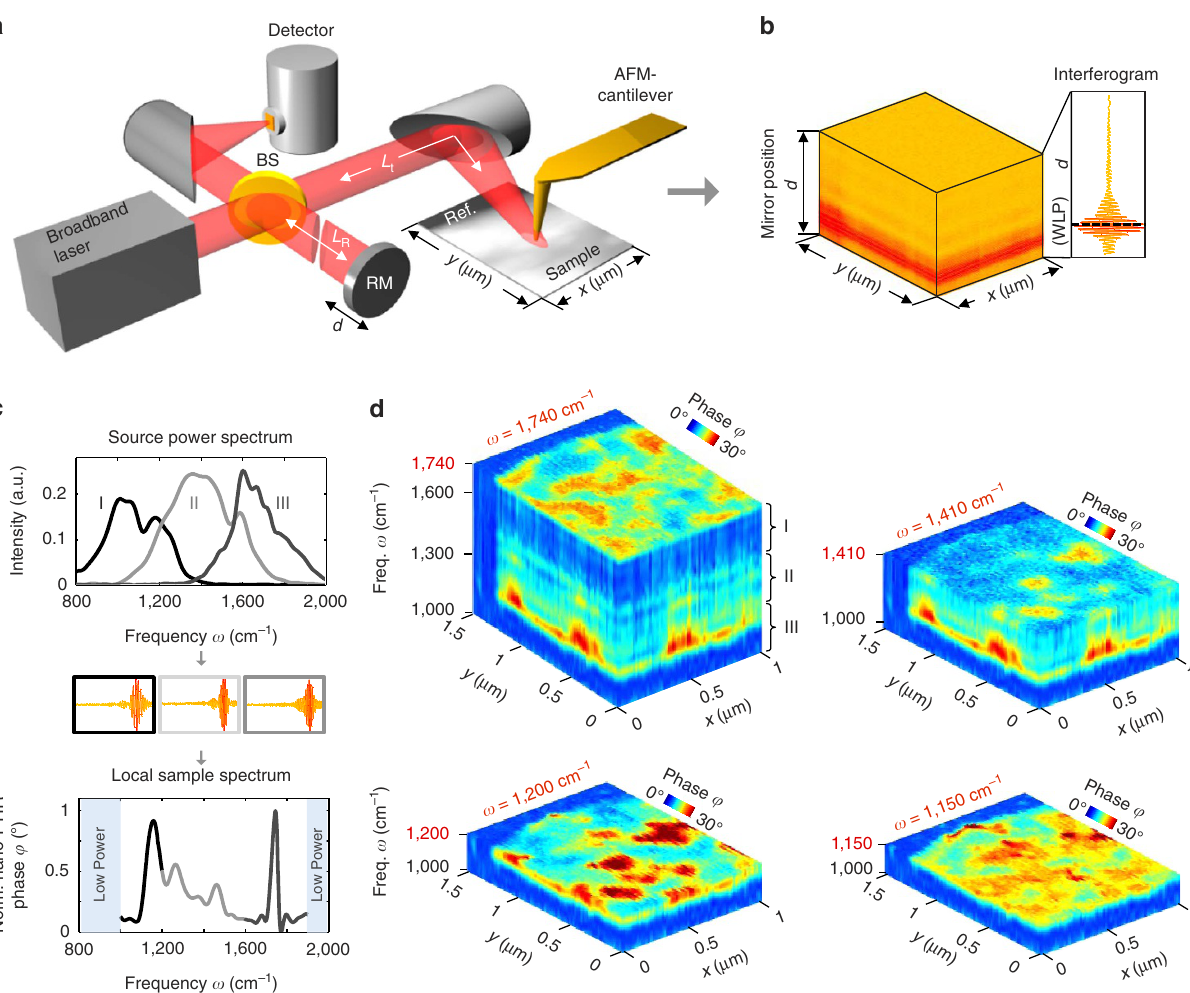
Figure 1 | Hyperspectral infrared nanoimaging. ( a ) Set-up employing a mid-infrared laser continuum source for tip illumination. The tip scans the sample surface while at each pixel the light backscattered from the tip is analysed with a Michelson interferometer that is operated as a Fourier transform spectrometer. The setup comprises a beam splitter (BS, uncoated ZnSe), a reference mirror (RM) and a detector. ( b ) 2D array of interferograms. ( c ) Top: Output spectra of the source. Middle: Interferograms recorded for each output spectrum. Bottom: Broadband nano-FTIR spectrum composed by three nano-FTIR spectra obtained by Fourier transform of the corresponding interferograms and normalization to a reference spectrum (middle panel). ( d ) Hyperspectral infrared data cubes of spectral resolution of 35cm (cid:2) 1 , cut at different frequencies o . They show the normalized phase j of the tip-scattered light as a function of position ( x , y ) and frequency o